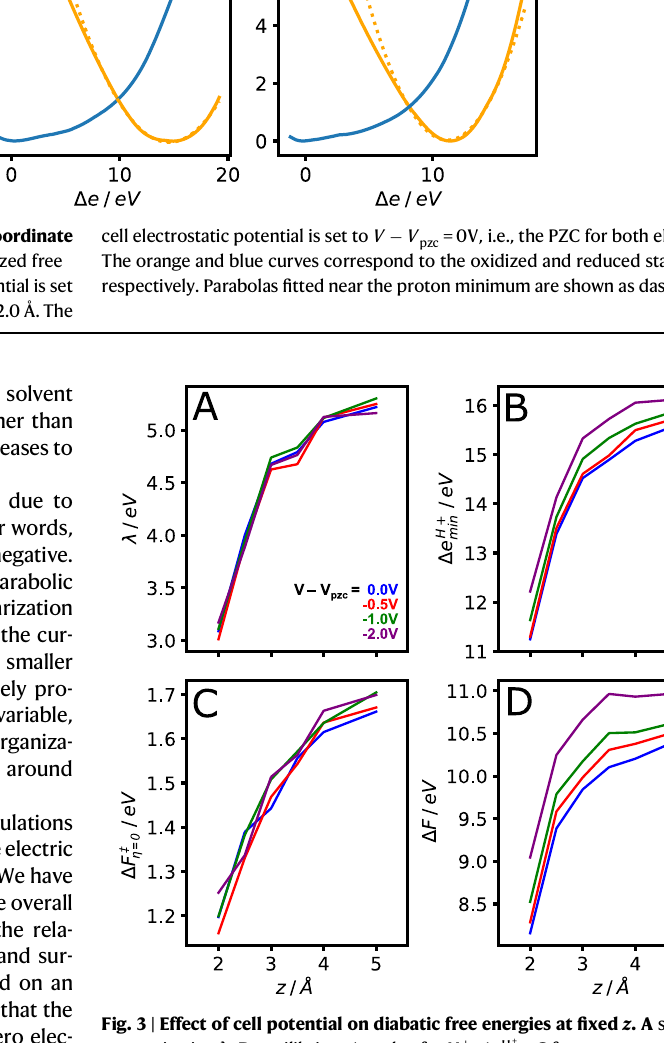
Fig. 3 | Effect of cell potential on diabatic free energies at fi xed z . A solvent reorganization λ ; B equilibrium Δ e value for H + , Δ e H + min ; C free energy to reach the diabatic crossing with the effect of overpotential subtracted off, Δ F z η =0 ; and D reduction free energy change, Δ F , for the diabatic curves where F H Δ e ð Þ = F H + Δ e ð Þ + Δ e . The blue, red, green, and purple curves are computed from diabatic free energy curves at electrode voltages relative to PZC of V (cid:2) V pzc =0V, (cid:2) 0 : 5V, (cid:2) 1V, (cid:2) 2V,